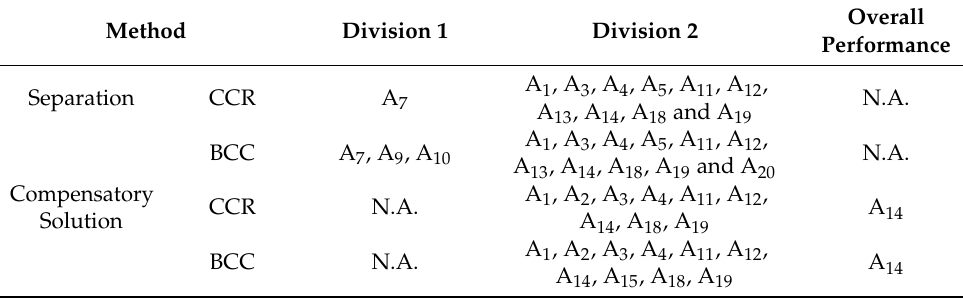
Table 11. Efficient DMUs in different analytic